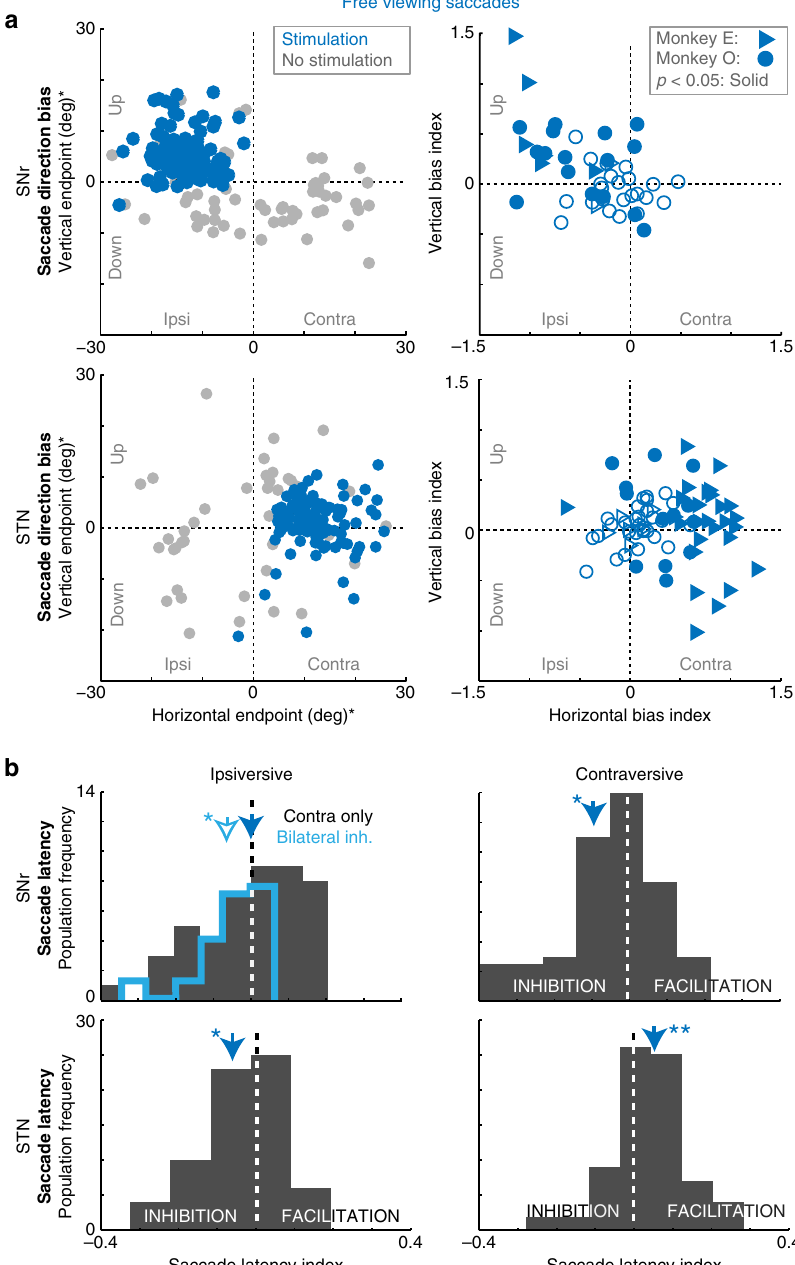
Fig. 3 SNr stimulation contraversively inhibited or bilaterally inhibited free viewing saccades, while STN stimulation contraversively facilitated free viewing saccades. Electrical stimulation was delivered across the left STN or SNr of 2 monkeys. In the SNr, 66% of stimulation sites affected saccade direction or frequency (paired t- test, p < 0.05). Of these, 40% were associated with an ipsiversive (left) bias of free viewing saccades with respect to the stimulated left hemisphere, whereas 47% were associated with a bilateral decrease in saccade frequency. In the STN, 62% of stimulation sites affected saccade direction or frequency (paired t- test, p < 0.05). Of these, 74% were associated with a contraversive bias of saccades, where saccade biases (i.e., contraversive facilitation, bilateral inhibition, etc.) were de fi ned based on a change in saccade frequency toward ipsiversive or contraversive visual hemi fi elds. a Left panels: representative SNr and STN stimulation sites, indicating an ipsiversive and contraversive bias of saccades, respectively. Each point indicates the end point of a single saccade (saccade start positions normalized to the origin), with overlaid control (gray) and stimulation (blue) trials. Saccade start points were standardized to the origin. Right panels: population direction bias index. Average saccade bias was quanti fi ed for each stimulation site, each point represents a single site. Filled points are signi fi cantly different from 0 (paired t -test, p < 0.05). Paired t -test, SNr: p < 0.001 both monkeys, n = 47; STN: p < 0.001 both monkeys, n = 76. b Population histograms of change in ipsiversive (left panels) and contraversive (right panels) saccade latency after stimulation. Negative and positive values indicate increased and decreased saccade latency after stimulation, respectively. *signi fi cant difference (paired t- test p < 0.05). **signi fi cant difference (paired t- test p < 0.001). Teal arrows and trace indicate the subset of SNr stimulation sites that bilaterally inhibited spontaneous saccades ( n = 21). These were analyzed separately, because there was no appreciable saccade direction bias